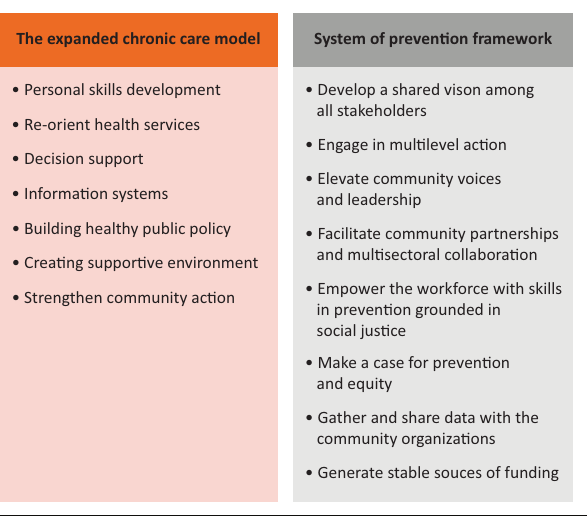
FIGURE 2: Elements of the expanded chronic care model and the system of prevention framework.